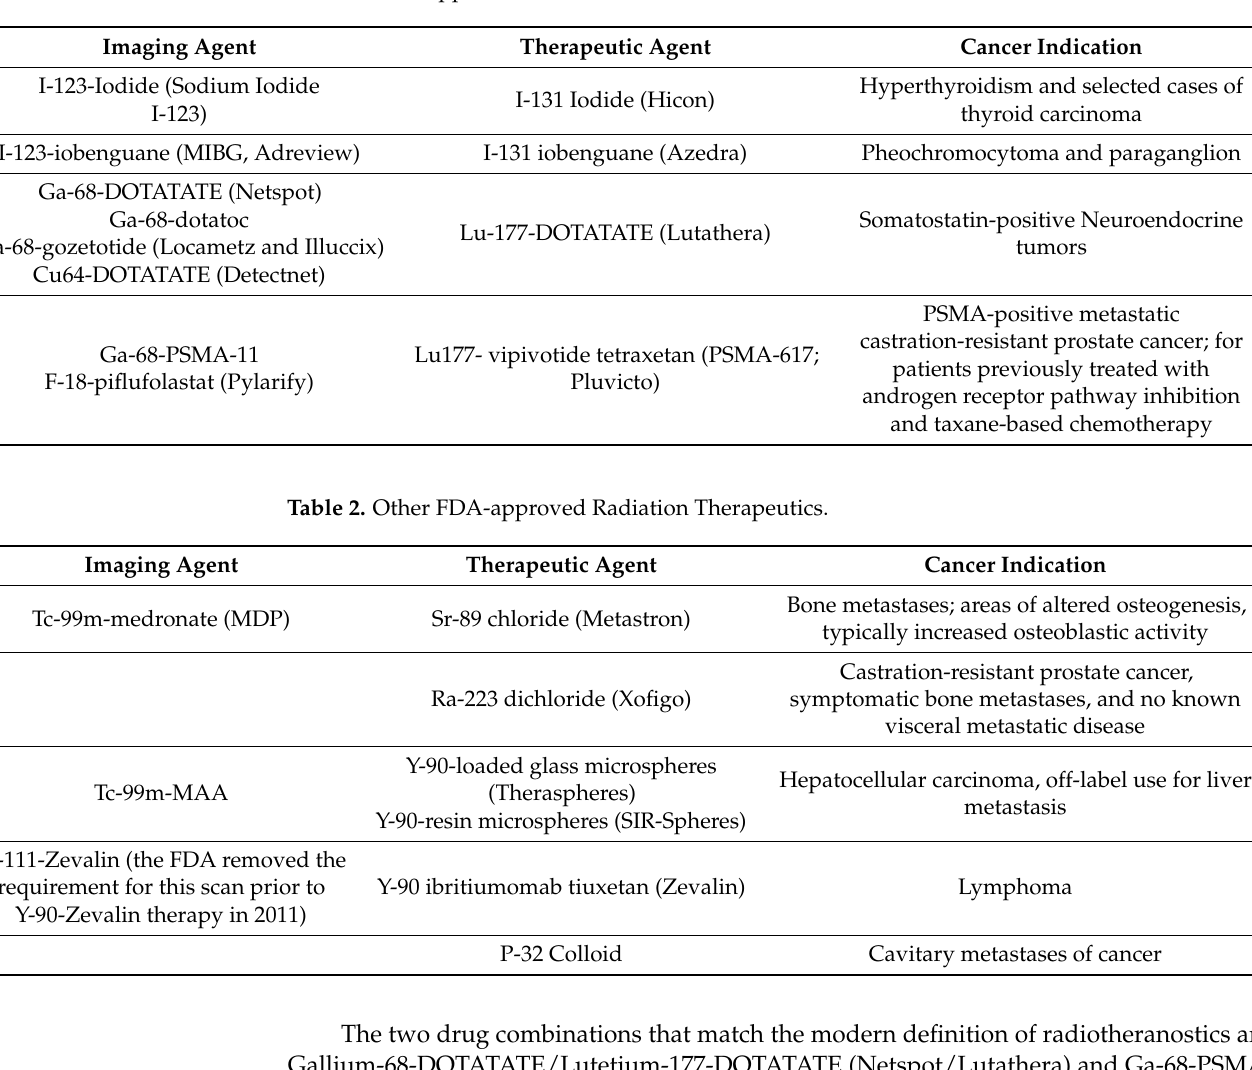
Table 1. FDA-approved Radiotheranostic Combinations.